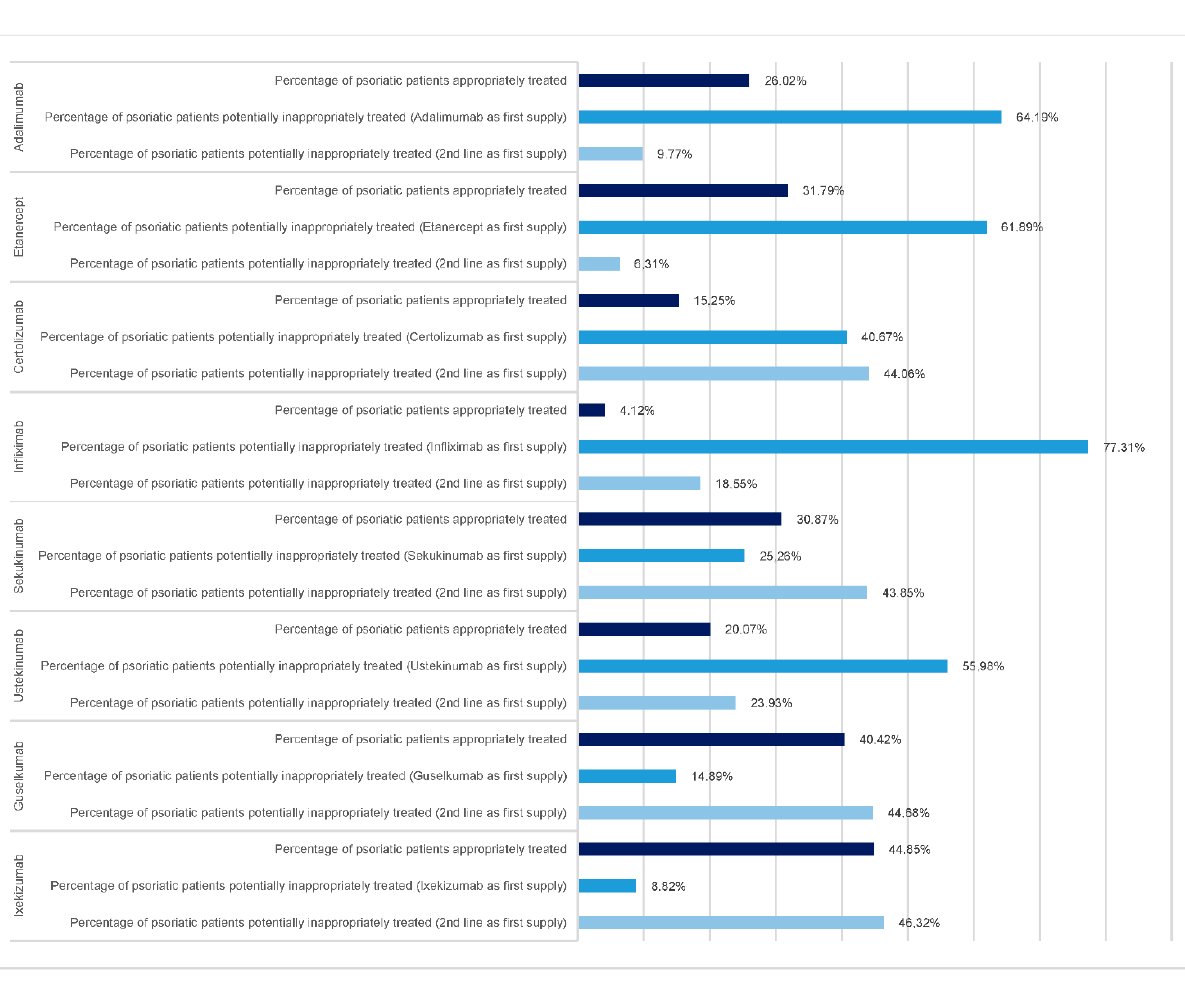
Figure 1. This figure reports the percentage of both appropriately and potentially inappropriately treated 2020 psoriatic patients for each mAb in Tuscany.